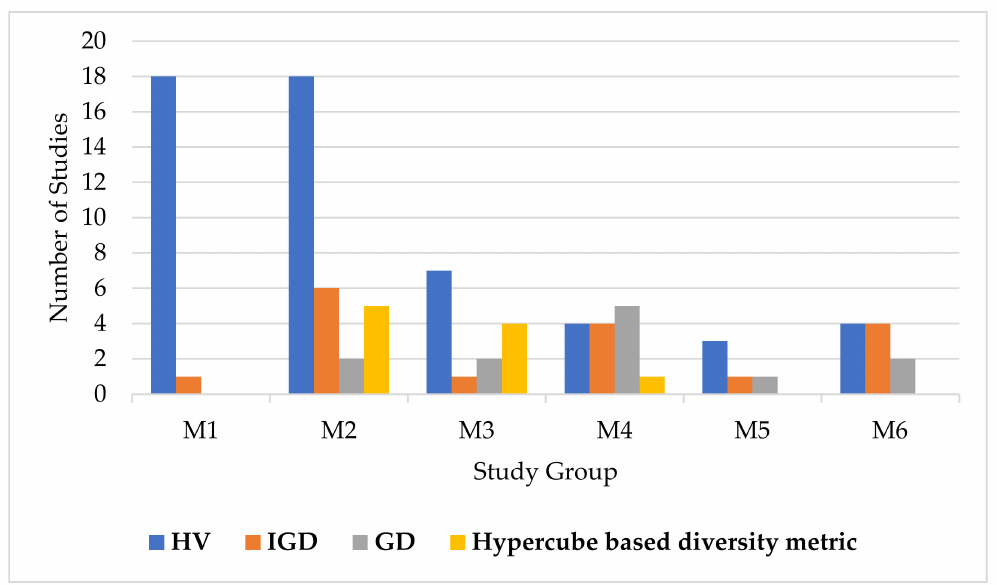
Figure 10. Top metrics distribution over the study